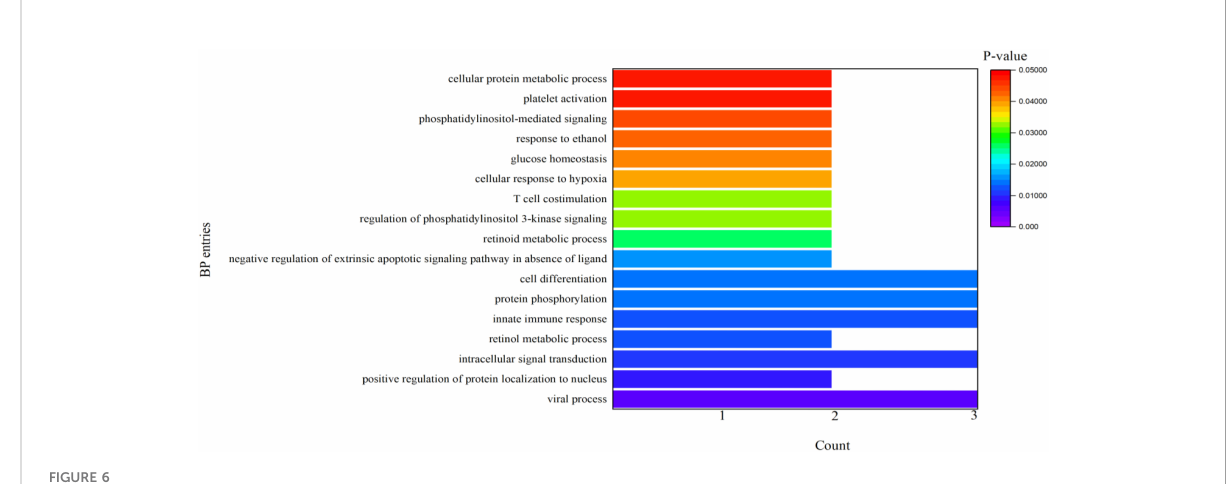
FIGURE 6 BP entries for the potential targets of active components in QFPD.